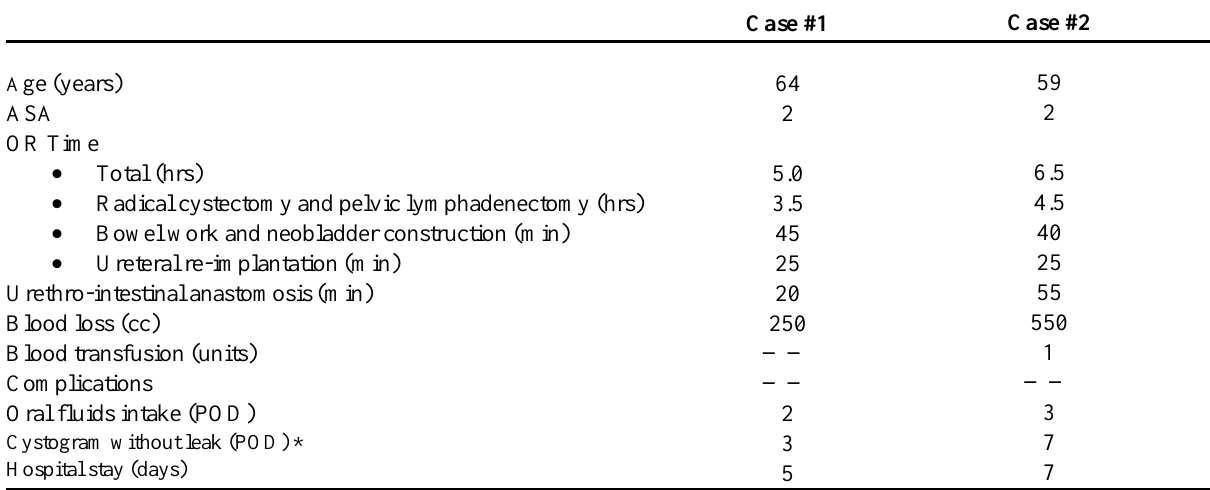
Table 1 – Demographics, intraoperative and postoperative